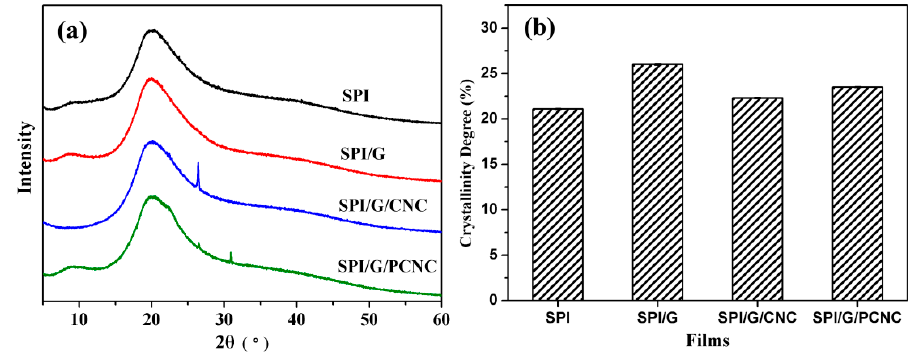
Figure 3. ( a ) XRD diffraction patterns and ( b ) crystallinity of SPI film and SPI-based films modified with graphene, CNC, and PCNC.